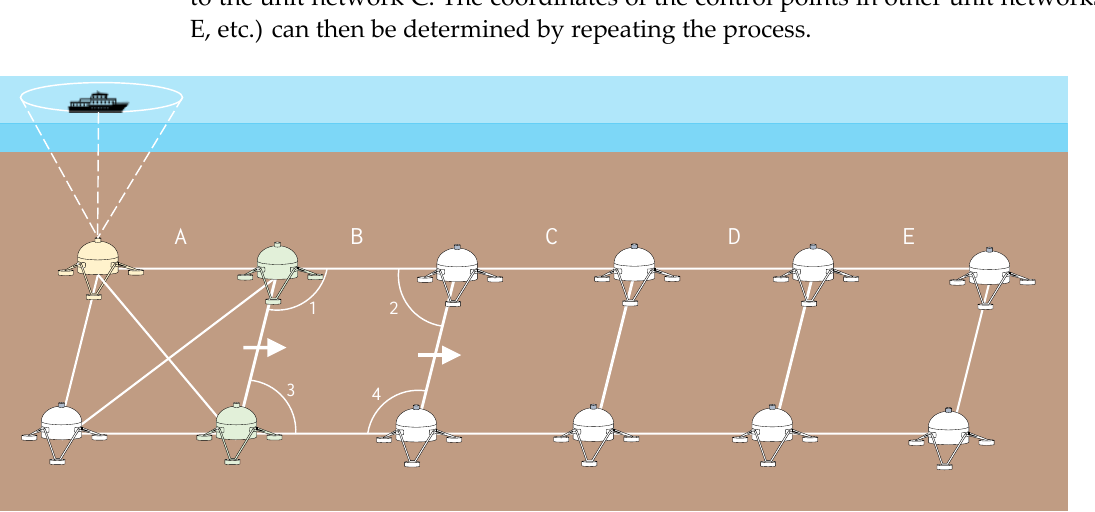
Figure 7. The principle of the chain coordinate transfer strategy. The yellow point is the known point. The green points are the common points between the unit network A and B. The white arrow is the direction of coordinate transfer.